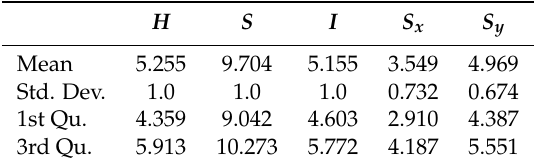
Figure 2. ( a ) Image with the spatial locations where the MFS observations were measured in Shelter V of Cova Remigia. ( b ) Observed MFS time series at every sampled spatial location on the surface. The number of available input variables to evaluate the covariance between spatial locations is 5 ( D = 5), which are the three image color variables per spatial location i ( i = 1, 2, . . . , N ): hue ( H i ), saturation ( S i ) and intensity ( I i ), and the two spatial coordinates S xi and S yi . Table 1 contains summary statistics for these input variables, which have been rescaled by dividing by their standard deviations. Spatial coordinates S x and S y were divided by their common standard deviation. Table 1. Summary statistics of the input